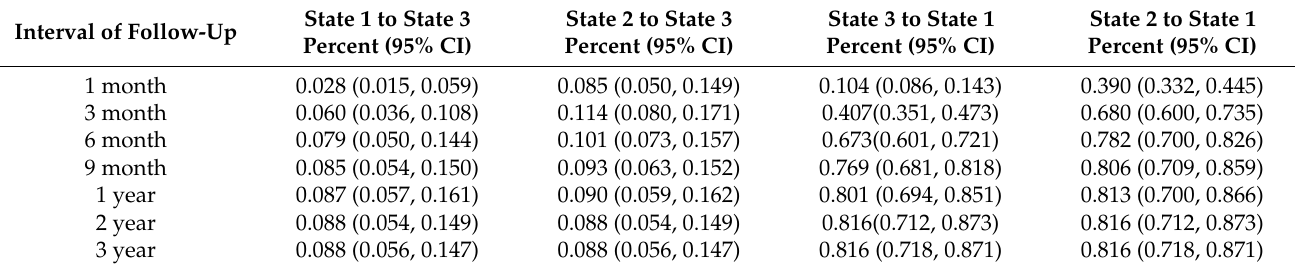
Table 4. Model-estimated transition probabilities over a given follow-up